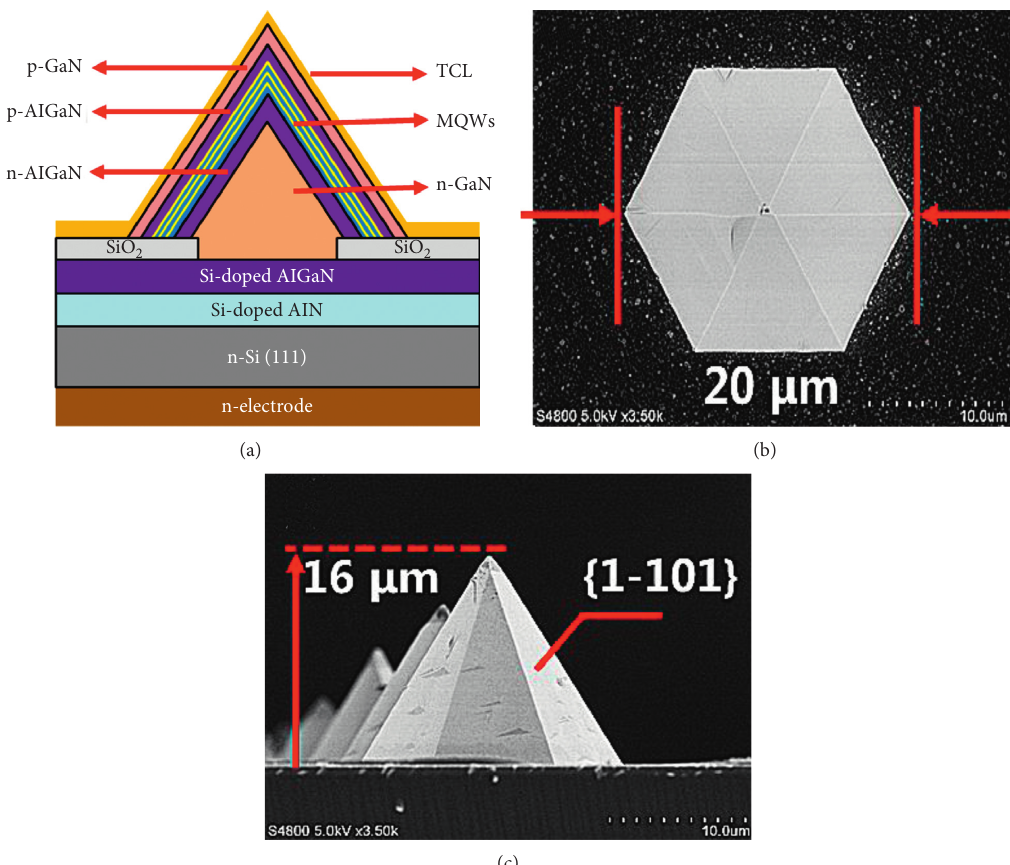
Figure 1: (a) Schematic diagram of the structure. (b) Top view and (c) front view SEM images of micropyramid UV LED of